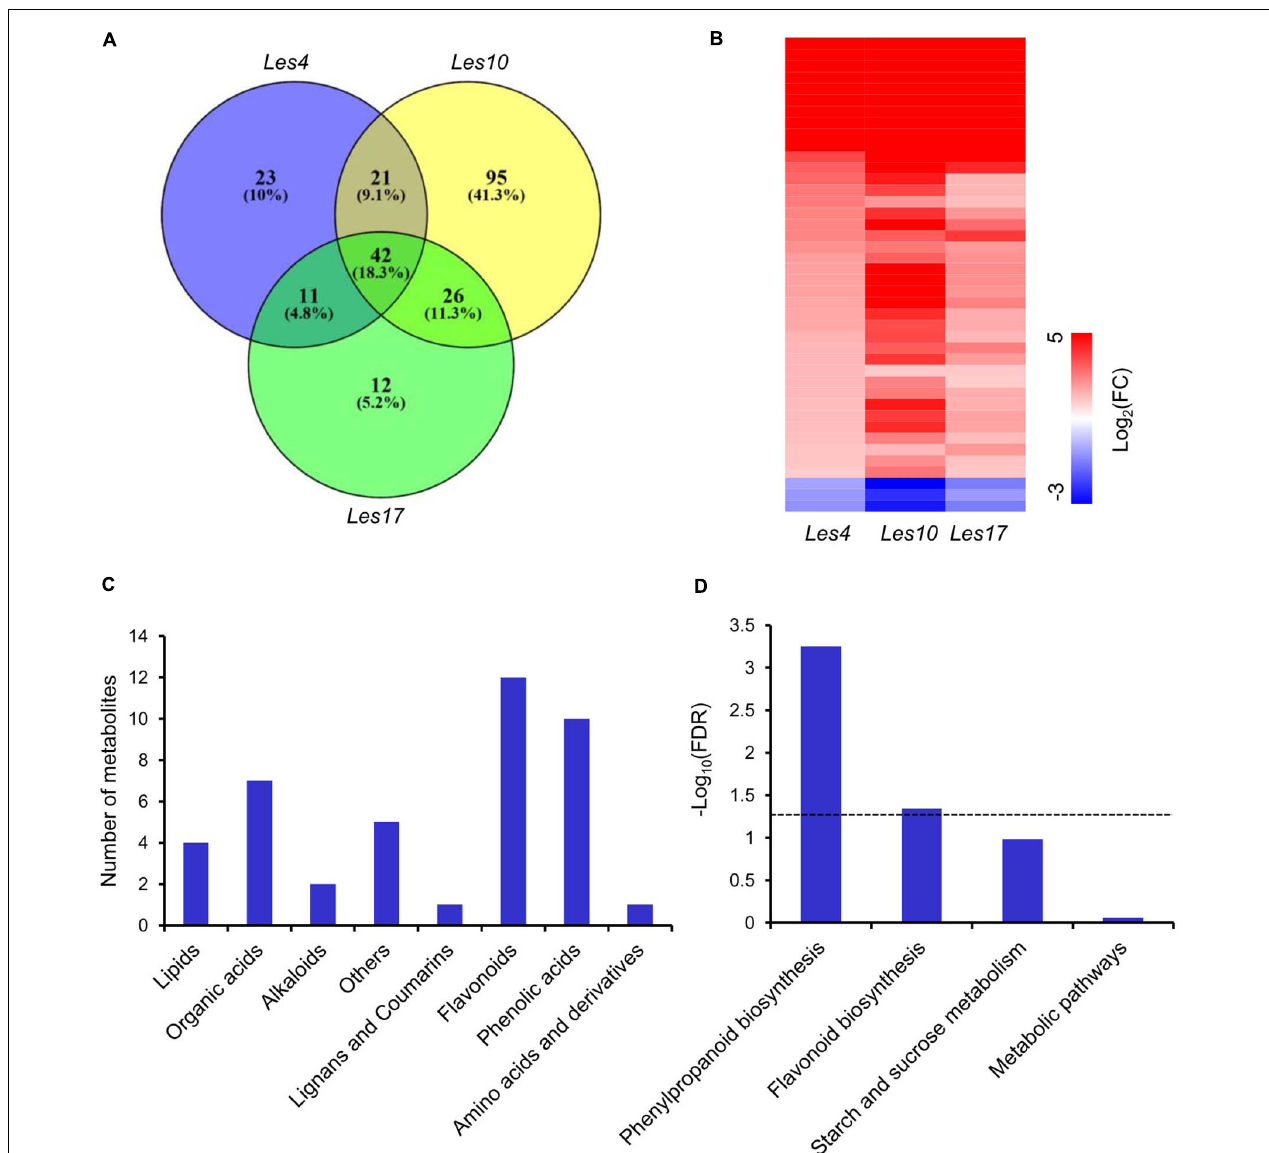
FIGURE 4 | Metabolomics analysis of Les4 , Les10 , and le17 . (A) Venn diagram displaying differentially accumulated metabolites unique and common in mutant vs. wild type in Les4 , Les10 , and Les17 . (B) Heatmap showing the differentially accumulated common metabolites in Les4 , Les10 , and Les17. (C) The number of common differentially accumulated metabolites (CMs) in different metabolite categories. (D) Kyoto Encyclopedia of Genes and Genomes (KEGG) analysis of CMs. The dash line represents a cutoff of p =